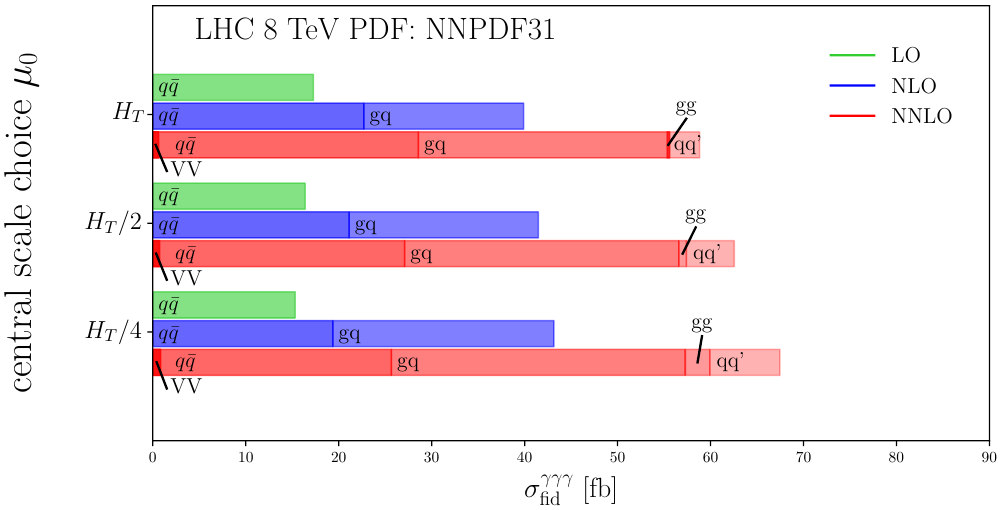
Figure 6 . Anatomy of higher-order corrections to the three-photon (cid:12)ducial cross-section at LO (green), NLO (blue) and NNLO (red) by partonic channels for three di(cid:11)erent central scale choices. Also shown is the contribution from the scale-independent part of the two-loop (cid:12)nite remainder (VV) computed in our approximation de(cid:12)ned in section